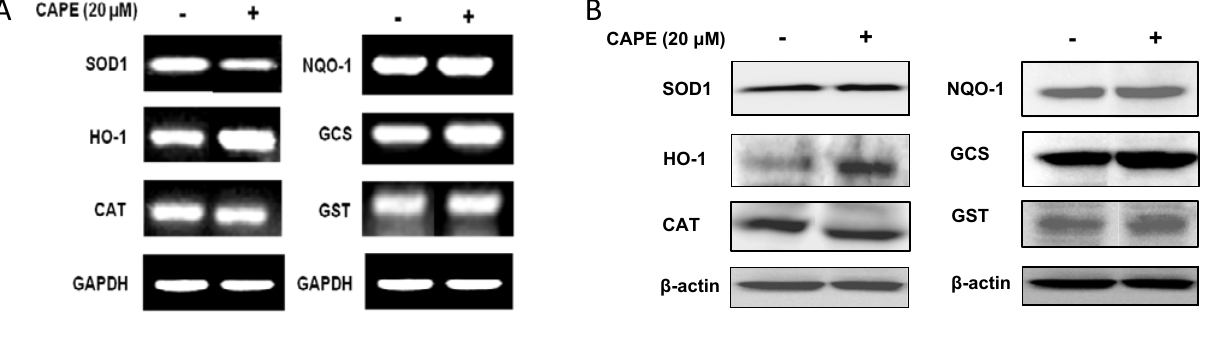
Figure 2. CAPE enhances HO-1 (heme oxygenase-1) mRNA and protein levels. After HepG2 cells were subjected to 20 μM CAPE for 12 h, the transcription and translation levels of phase II antioxidant and detoxifying enzymes in HepG2 cells were determined using reverse transcription-polymerase chain reaction (RT-PCR) and western blot analysis respectively. ( A ) mRNA level of phase II antioxidant and detoxifying enzymes; ( B ) Protein level of phase II antioxidant and detoxifying enzymes; ( C ) CAPE increases HO-1 mRNA level; ( D ) CAPE augments HO-1 protein level. Data are expressed as mean ± standard deviation of three individual experiments, *** p <0.001 vs. vehicle. SOD1, superoxide dismutase 1; HO-1, heme oxygenase-1; CAT, catalase; NQO1, NAD(P)H:quinone oxidoreductase 1; GCS, glutamylsysteine synthase; GST, glutathione